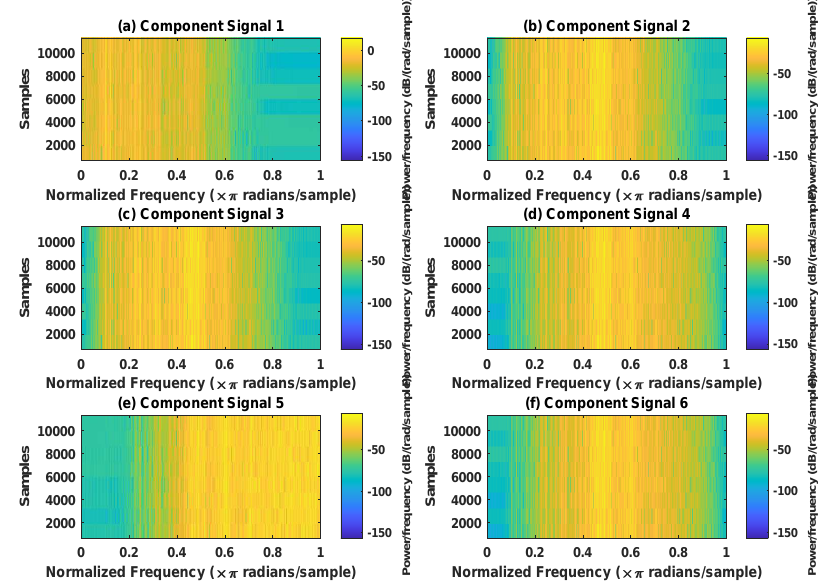
Figure 19. Decomposition results of SVDP with m = 16 and J = 3: ( a – f ) time–frequency diagram of 1st to 6th subcomponents,